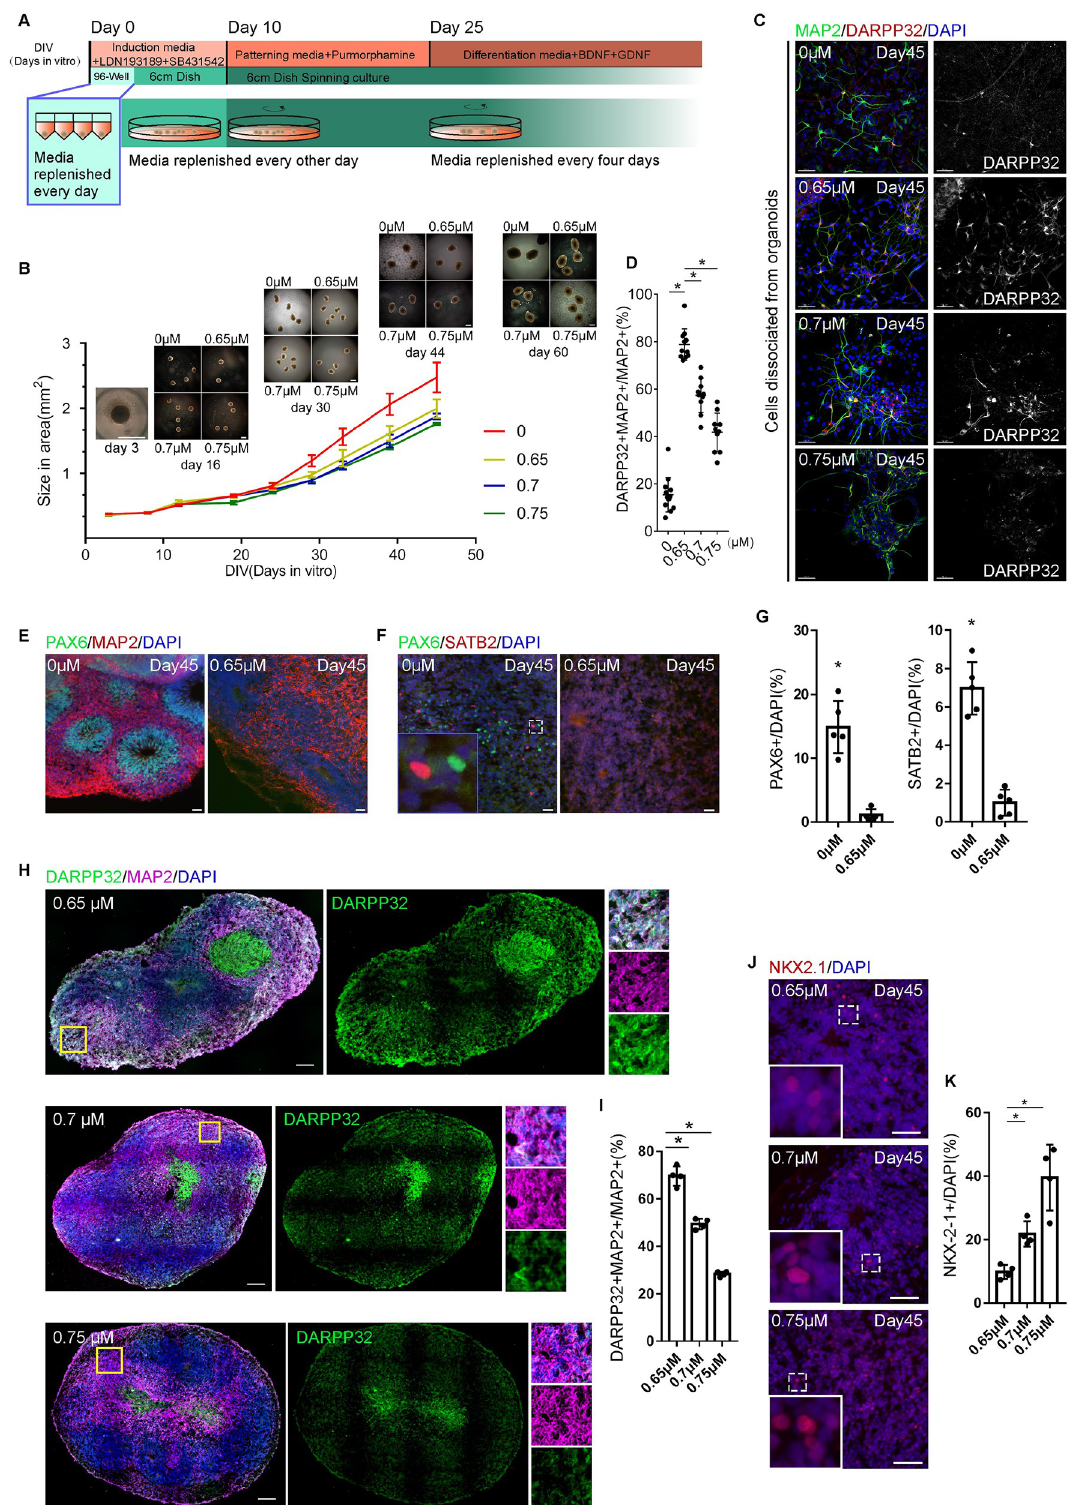
Fig 1. AU : AbbreviationlistshavebeencompiledforthoseusedinFigs 1 to 6 : Pleaseverifythatallentriesarecorrect : Generating human striatal organoids. (A) The schematic of brain organoid protocol with a ventral drug-patterning application (purmorphamine) during culture. (B) The morphology of organoids with different concentrations of ventral drug- patterning applications in culture. Scale bar, 1 mm. Quantification of organoid size from Day 0 to Day 44 in cultured (mean ±